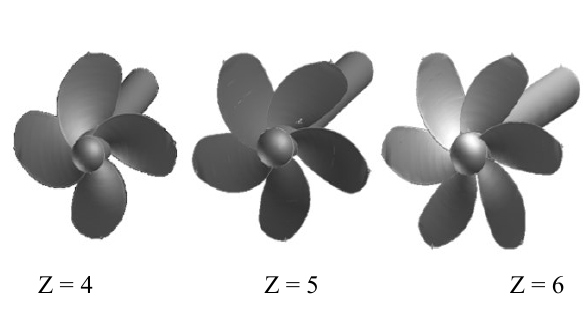
Fig. 1. Blade shape and propeller geometry